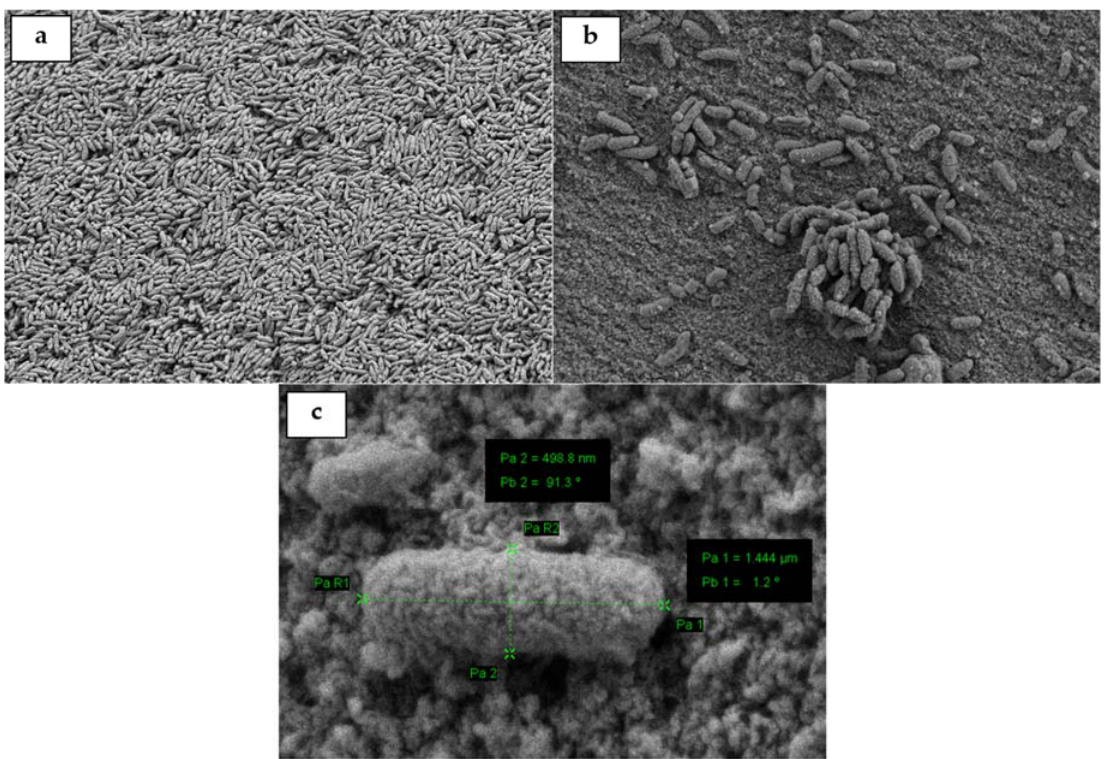
Figure 3. FESEM image of isolate KBH 6958 at ( a ) magnification of 2000×; ( b ) magnification of 5000× g showing nano ‐ interlinkages among the bacteria; and ( c ) magnification of 10,000× g showing indi ‐ vidual bacterium.